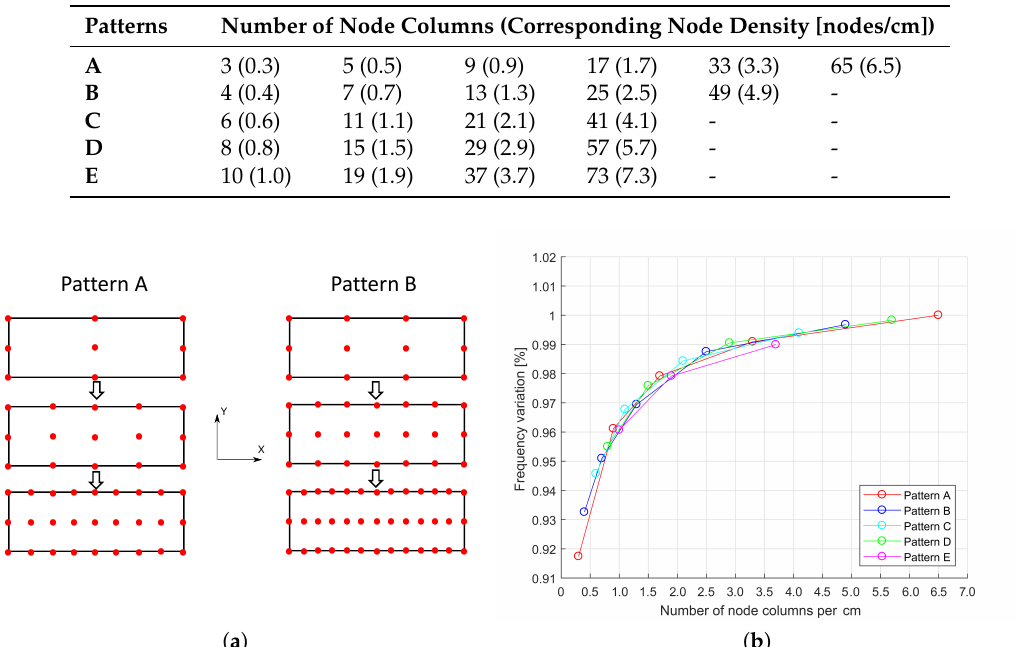
Table 2. Pattern of nodes retained during the reduction procedure.